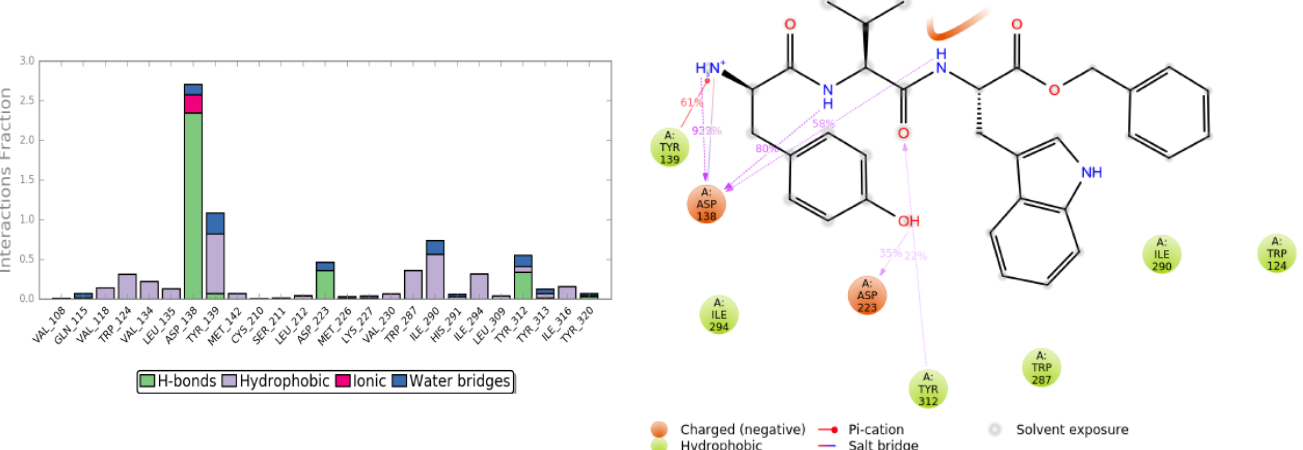
Figure 10. Interactions of H-D-Tyr-Val-Trp-OBz ( 11 ) within the KOR binding pocket, expressed in %. Hydrogen bonds are in violet lines.